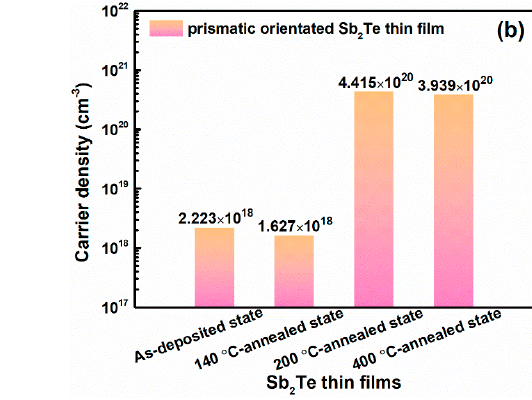
Figure 9. ( a ) Carrier mobility of as-deposited and annealed Sb 2 Te thin films (200 nm) with prismatic texture and random orientation. Data of as-deposited and 200 °C annealed Sb 2 Te thin films with random orientation from reference [27]. ( b ) Carrier density of as-deposited and annealed Sb 2 Te thin films (200 nm) with prismatic texture.